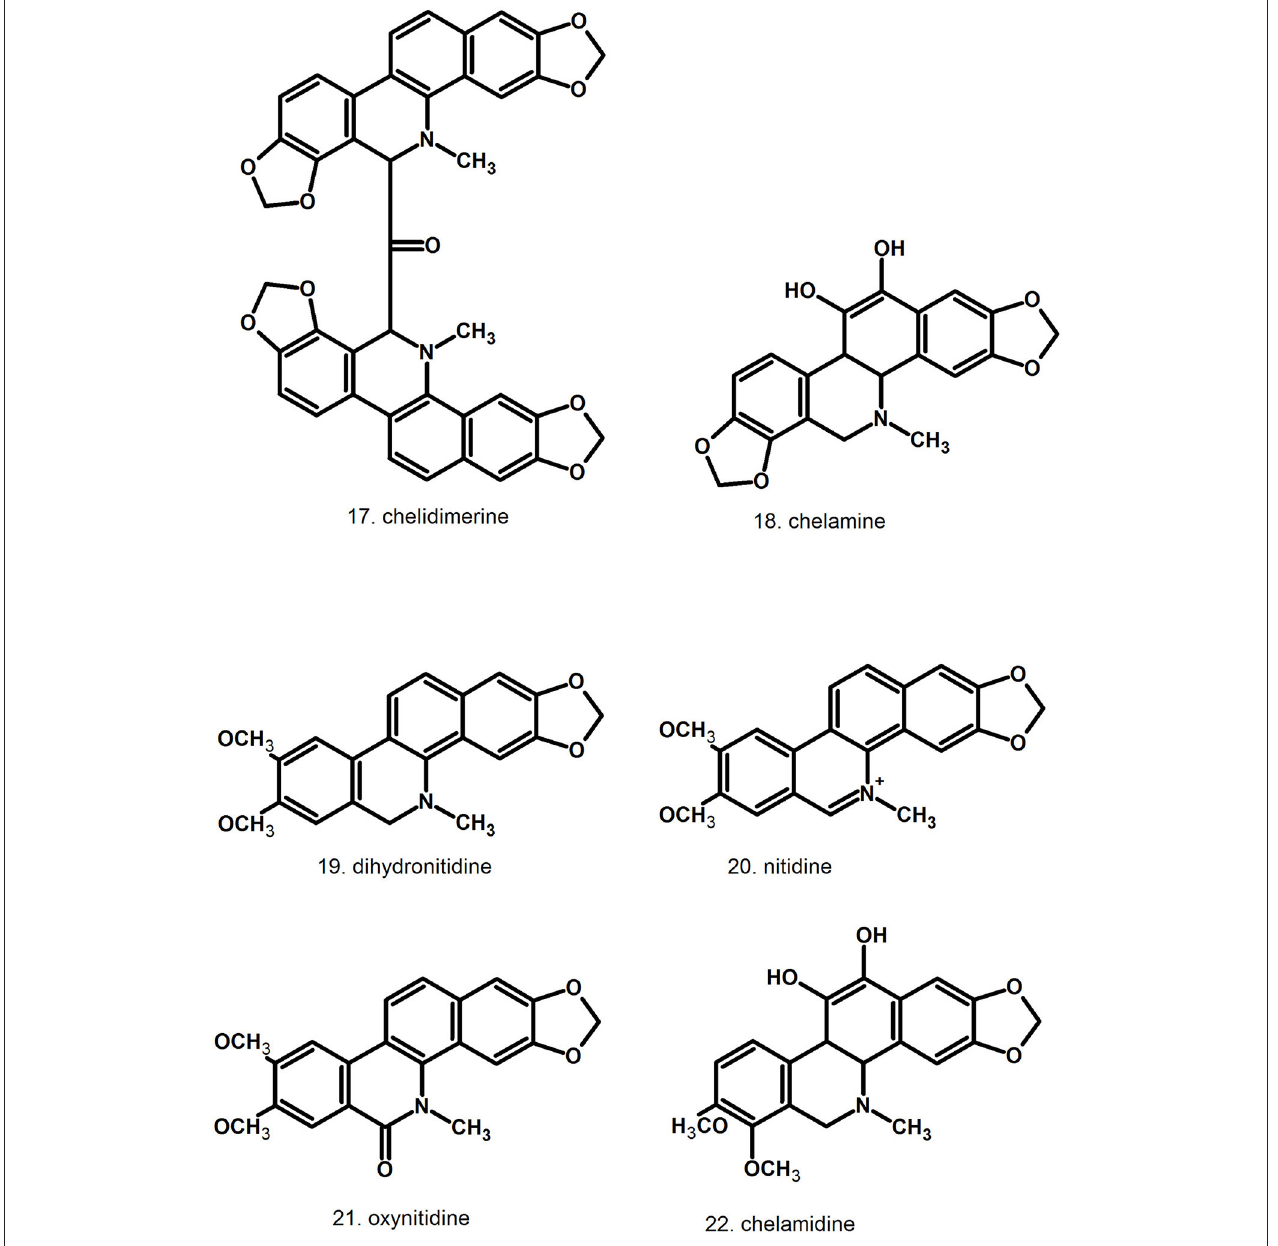
FIGURE 3 | Further structures of minor phenanthridine (3,4-benzoisoquinoline) alkaloids.